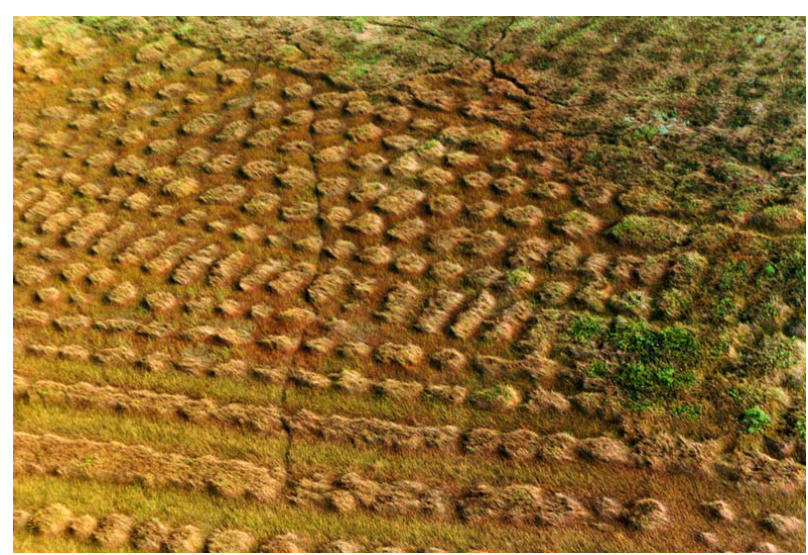
Figure 8. Medium raised fields.